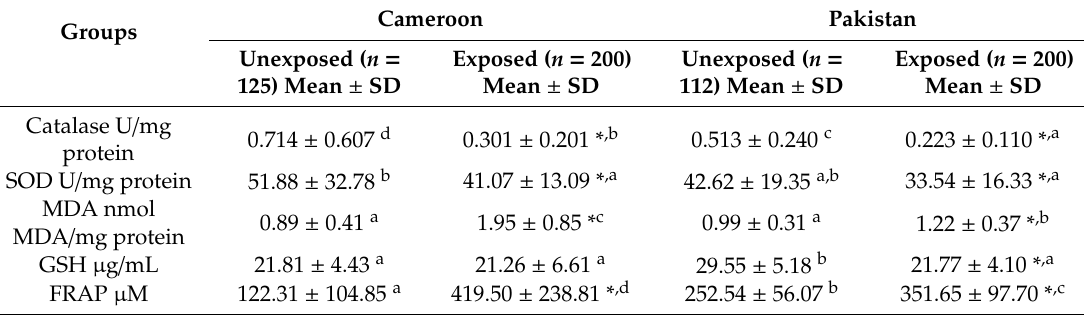
Figure 1. Blood pesticides levels in Cameroonian and Pakistani groups. Table 3. Status of antioxidant enzymes in unexposed and OP-exposed groups.